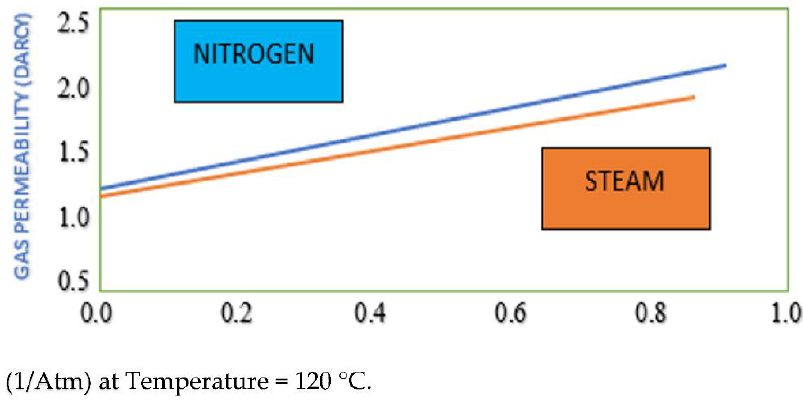
Figure 8. Comparison of the nitrogen and steam gas distribution factor test.